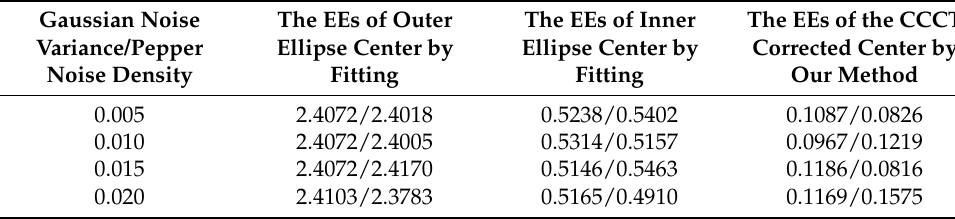
Table 1. The EEs under different image